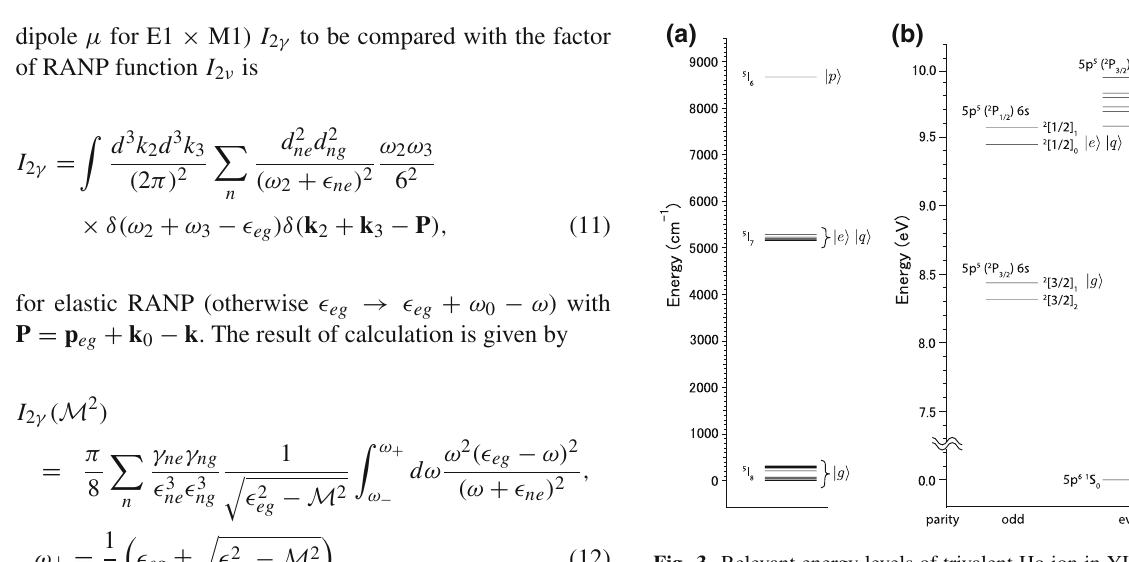
Fig. 3 Relevant energy levels of trivalent Ho ion in YLF and neutral Xe. a Ho in the unit of cm − 1 (10 4 cm − 1 = 1 . 24eV in the natural unit). ThereareanumberofsplitStarkstatesundercrystalfieldthatcontribute as states, | q (cid:2) and | g (cid:2) . b Xe in eV